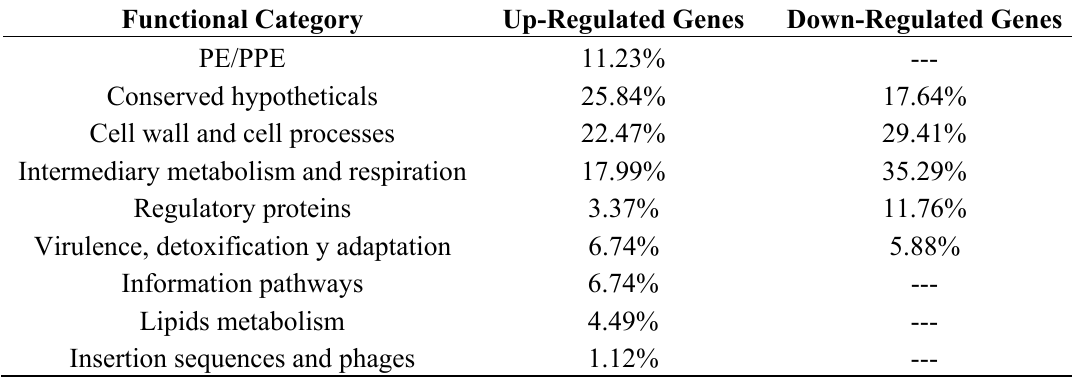
Table 1. Functional category of up- and down-regulated genes observed in microarrays analysis obtained from M. tuberculosis H37Rv exposed to different concentrations of MDGA.